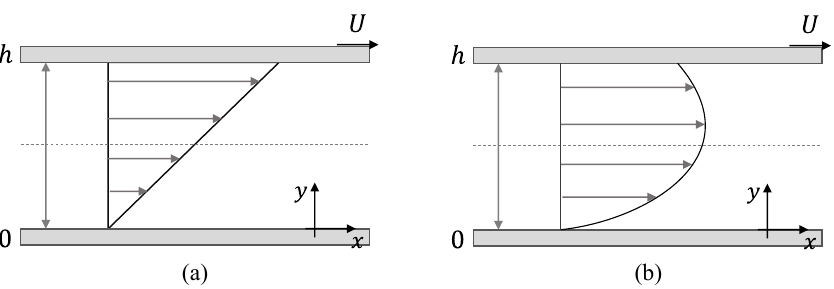
Figure 3. Geometry of: ( a ) the pure Couette flow; and ( b ) the Couette flow with an imposed pressure gradient (Poiseuille–Couette